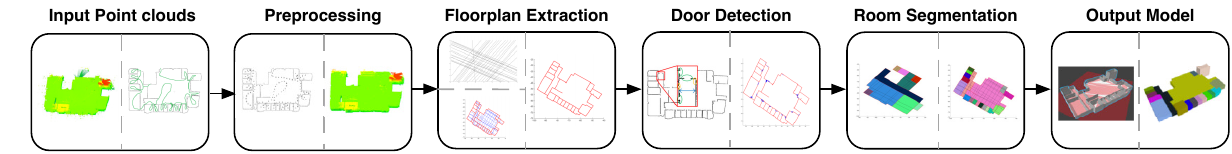
Figure 1. The Pipeline of Methodology: 1) preprocessing; 2) floorplan extraction; 3) door detection; 4) room segmentation; 5) output 3D modeling.